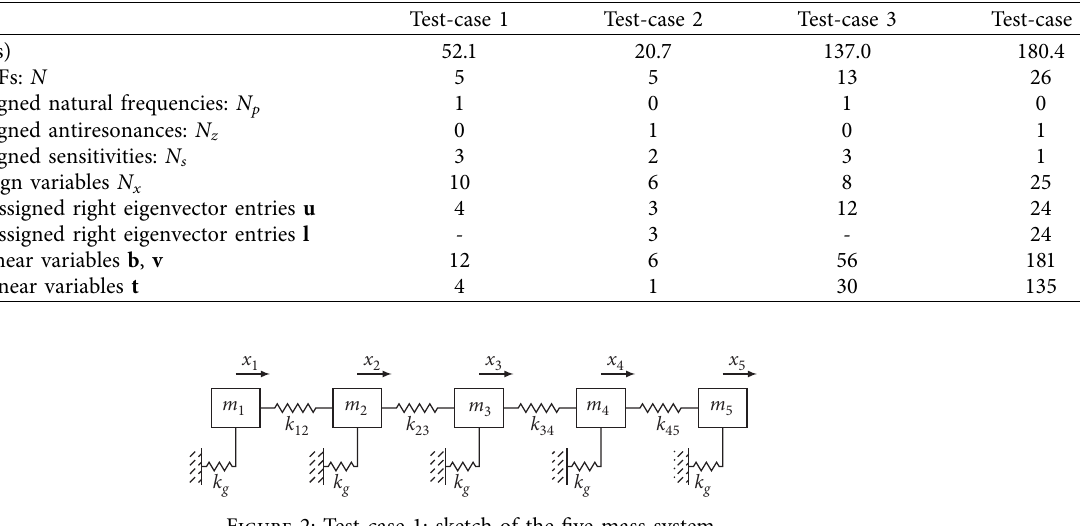
Table 1: Summary of the computational details of the test cases.